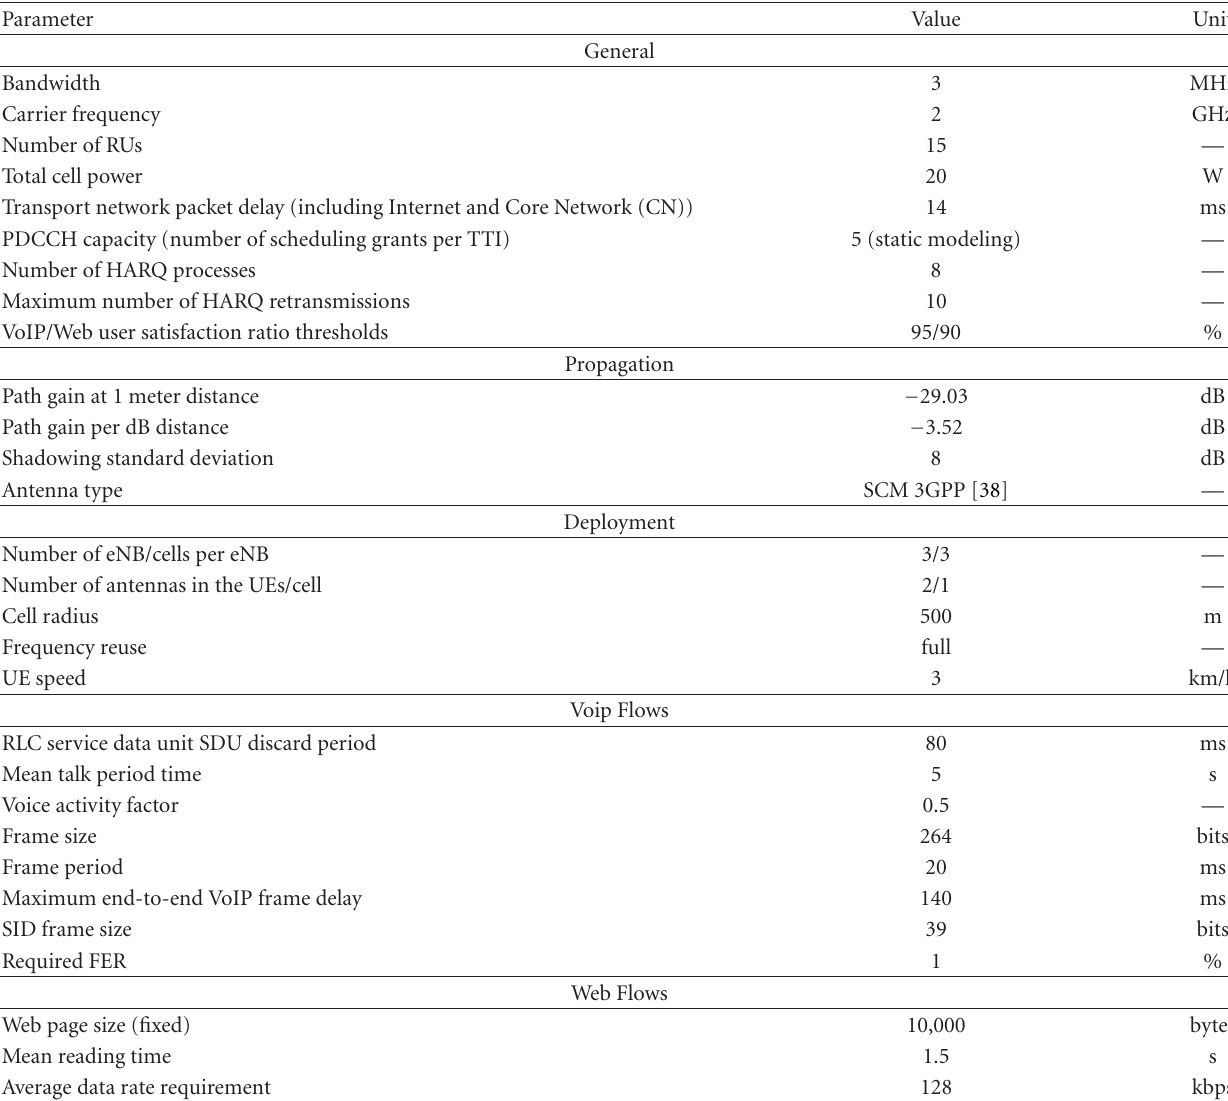
Table 1: Main simulation parameters considered in this work. The parameters are classified in general parameters of LTE, propagation, deployment, and service-specific